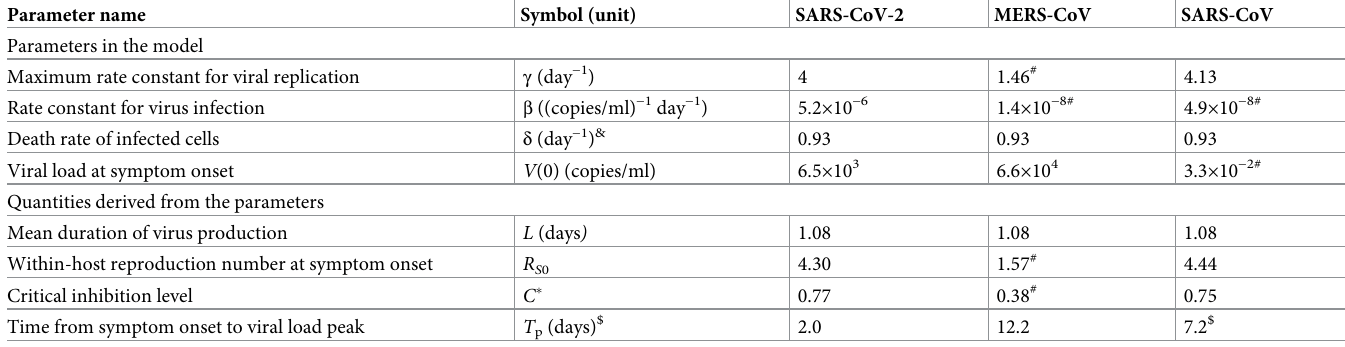
Table 1. Estimated parameters (fixed effect) for SARS-CoV-2, MERS-CoV, and SARS-CoV